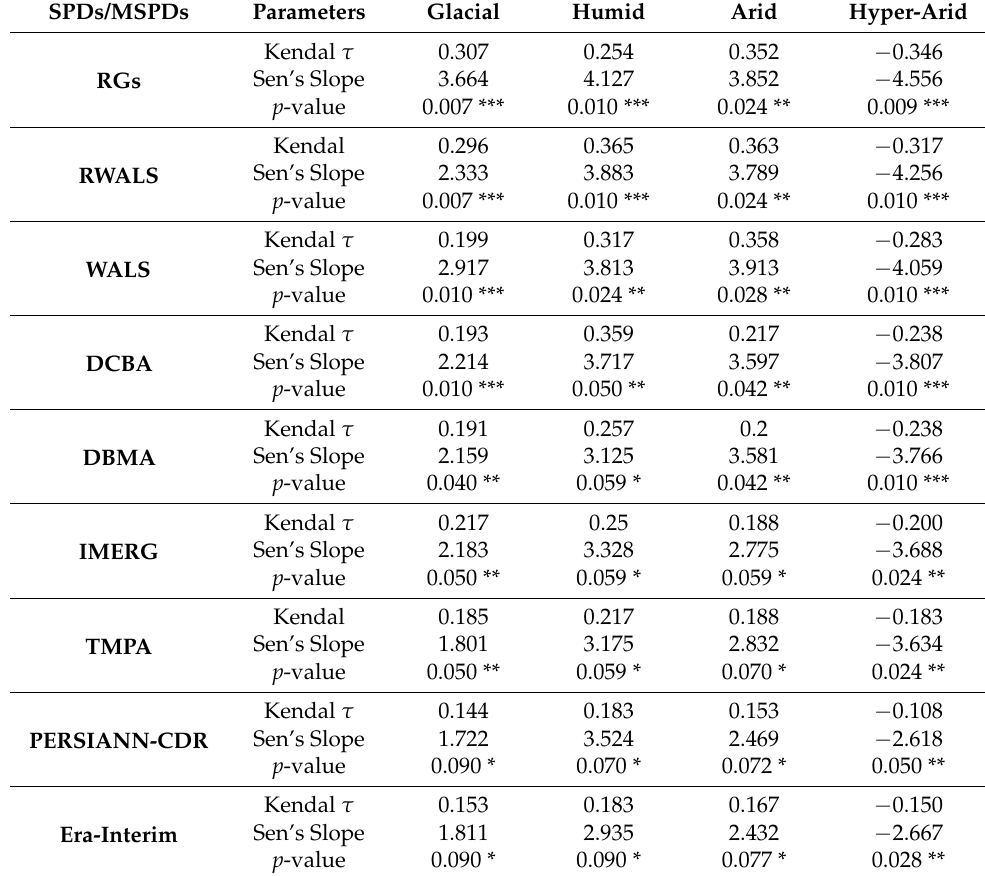
Table 7. MK trend and level of significance for SPI-1 estimated for RGs, SPDs, and MSPDs across all climate regions. The p -values less than 0.01, 0.05, and 0.10 show that the trend is significant at the significance level of 1%, 5%, and 10% and marked with ***, **, and *, respectively.